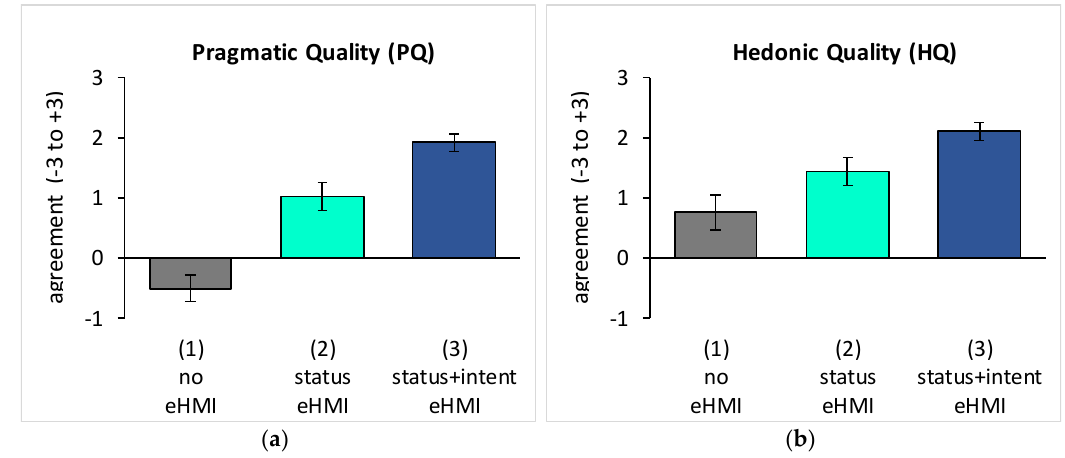
Figure 10. Mean UX scores for all driverless self-driving vehicle (SDV; automated mode) test conditions, as shown by the subscales: ( a ) Pragmatic Quality (PQ) and ( b ) Hedonic Quality (HQ). Error bars: ± 1 SE.